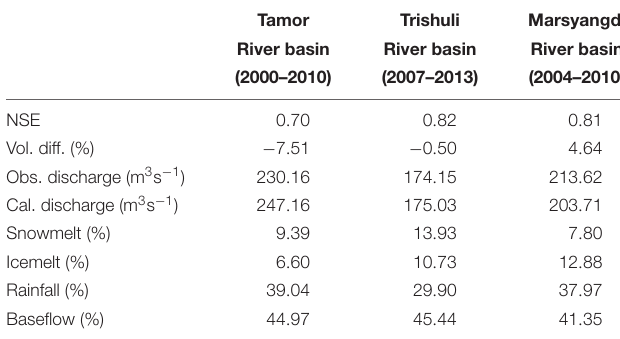
FIGURE 4 | Monthly partition of snowmelt, icemelt, rain and baseflow contributions in (A) Tamor, (B) Trishuli, and (C) Marsyangdi River basins. TABLE 4 | Results of the GDM runs.